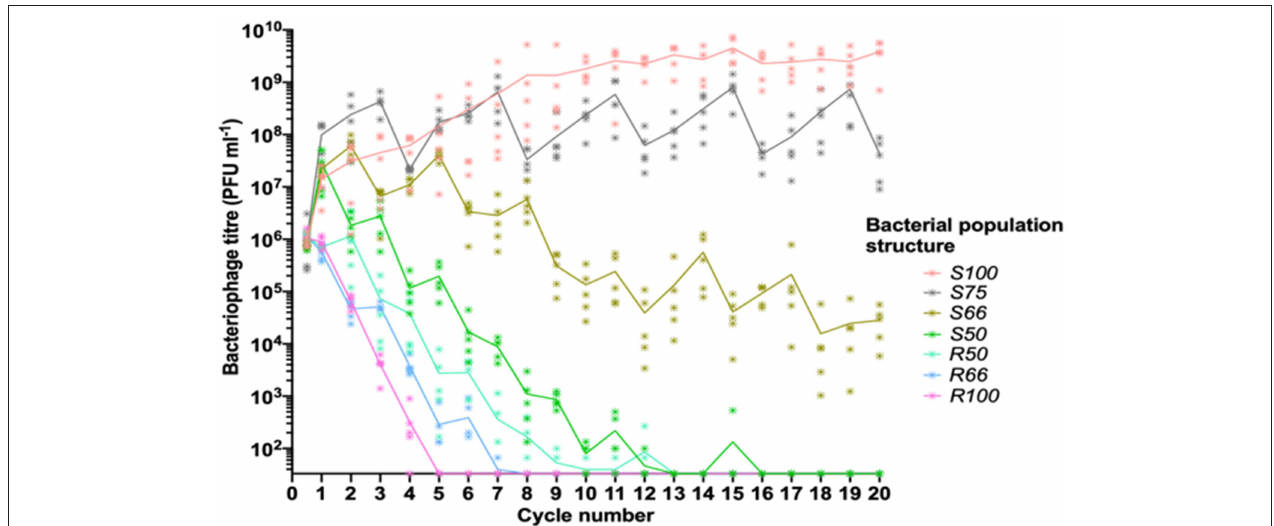
FIGURE 2 | Linear oscillating prey assay for phage HP1c1 infections of H. influenzae strain Rd populations with varying population structures for lic2A expression. This assay utilizes the format indicated in Figure 1A . Each line represents cycling of the phage through a defined series of cultures of two H. influenzae strain Rd phase variants, namely Rd30S (S; lic2A ON; phage susceptible) and Rd 30R (R; lic2 OFF; phage resistant). The population structures are indicated in the legend (i.e., S100, all S; S75, S-S-S-R; S66, S-S-R-S-S-R; S50, S-R-S-R; R50 R-S-R-S; R66, R-R-S-R-R-S; R100, all R). The phage HP1c1 titer was determined at the end of each cycle. Points represent the phage titer observed from each of five biological replicates, with the line showing the mean of these replicates.